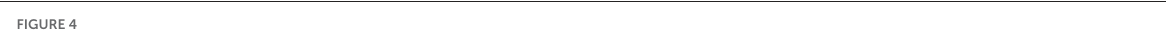
FIGURE4 (PCoA) based on the unweighted Unifrac distances. (C) The composition of rumen microbiome at phylum and genus level: the composition of rumen microbiome at phylum level (a) , the composition of major rumen genera (b) . (D) LEfSe identified significantly different bacteria at the genus level as differentiating the two groups, including Ctrl vs. ES (a) , Ctrl vs. ES + EW (b) , and ES vs. ES + EW (c) . Genera in this graph were statistically significant ( P < 0.05) and had an LDA Score > 2.5, which was considered a significant effect size; (E) Heat maps showing the correlations between animal phenotypical variables and relative abundance of bacterial genera. The depth of the color indicates the correlation between species and environmental factors. “ * ” and “ ** ” indicate the different levels at 0.05 and 0.01, respectively.